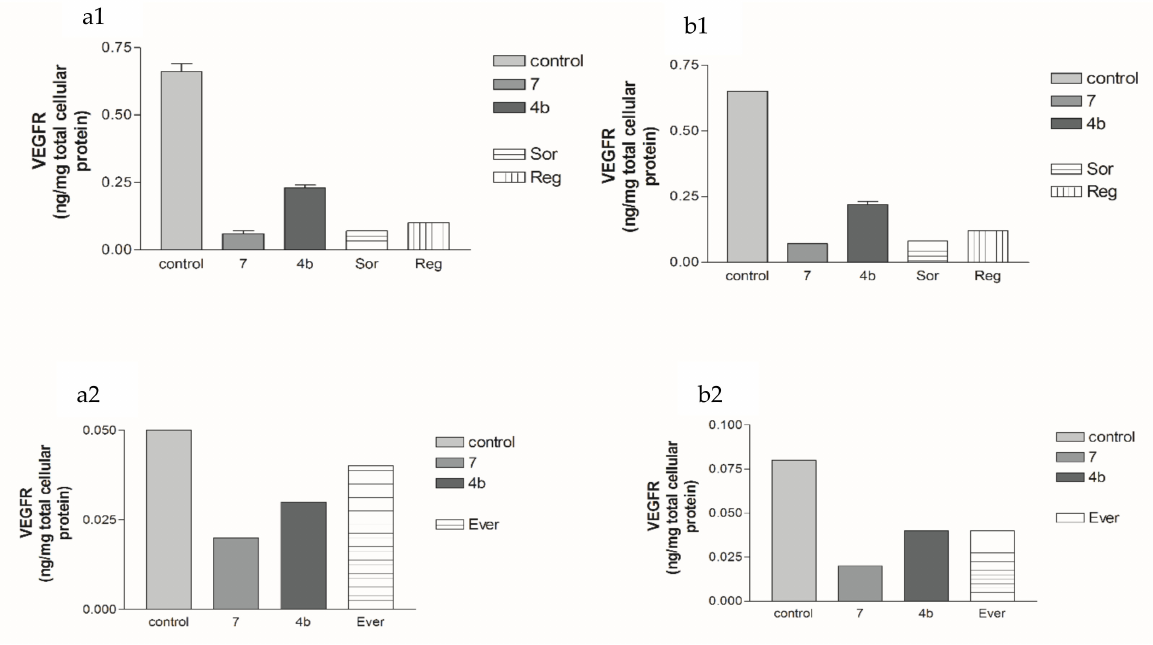
Figure 7. Compounds 7 and 4b and reference medications’ effects on the VEGFR-2 protein expression level (ng/mg tissue protein) in HEPG2 and MCF-7, where ( a1 , a2 ) at 24 h and ( b1 , b2 ) 72 h, all therapies were provided for 3 successive days. Results are given as mean ±